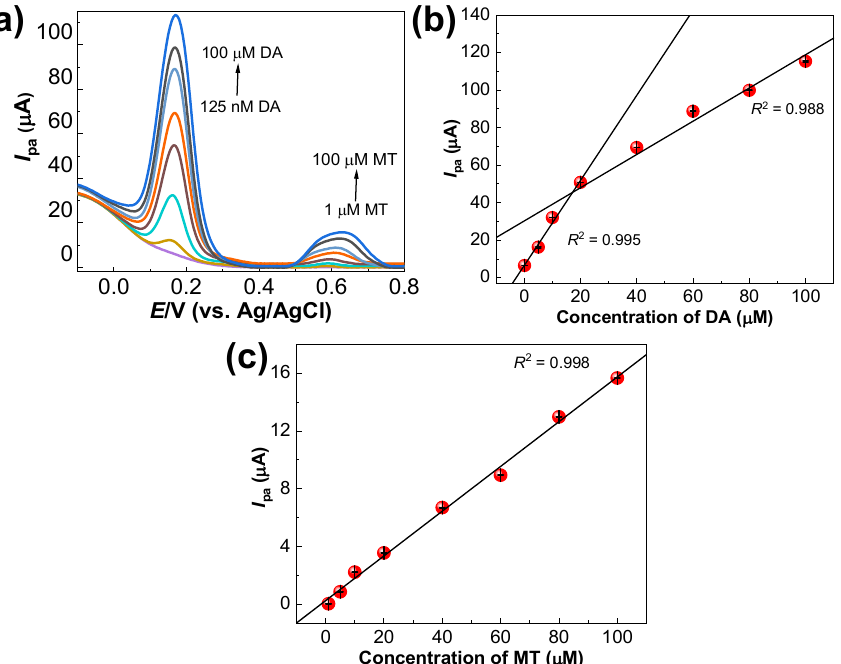
Figure 10. ( a ) DPV responses of the Cu–CNS/SPCE for the simultaneous detection of DA from 125 nM to 100 μM and MT from 1 μM to 100 μM. ( b ) DA showing two linear ranges (125 nM to 20 μM) and (20 μM to 100 μM) ( c ) MT calibration plot illustrating a wide linear range from 1 μM to 100 μM concentrations. Table 1. Comparative study of the electrochemical sensors for the simultaneous determination of DA and MT.